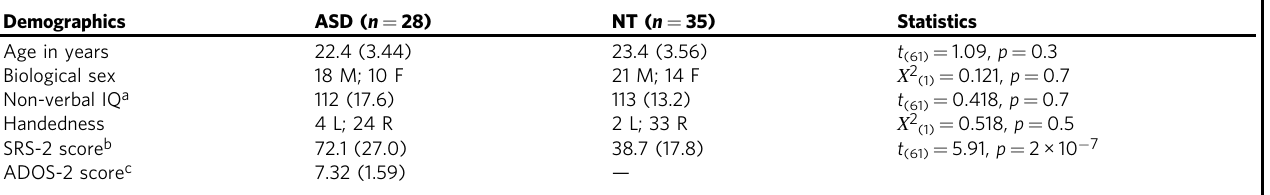
— Values shown are group mean and SD. Results of statistical tests for group differences are shown on the right. Two-sample t tests and chi-square tests were used to assess group differences. a Non-verbal IQ was calculated based on the Wechsler Abbreviated Scale of Intelligence